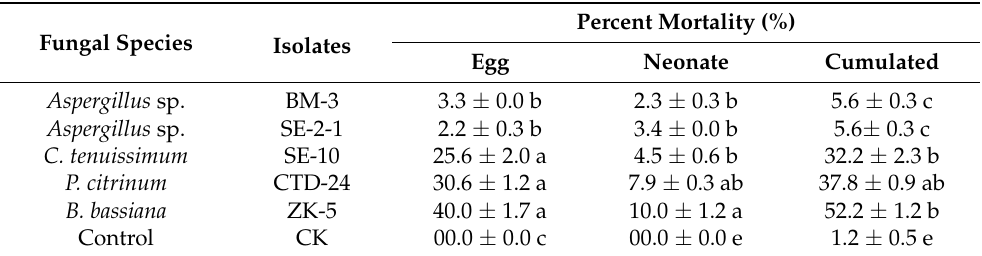
Table 4. Effects of fungal isolates on cumulative mortalities of eggs and neonates at 1 × 10 6 conidia mL − 1 .